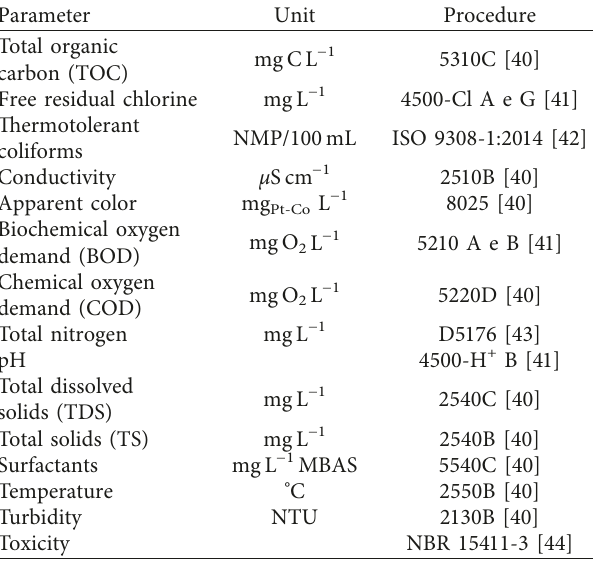
Table 1: Physicochemical parameters evaluated for the charac- terization of the laundry wastewater, determination methods, and analytical protocols.